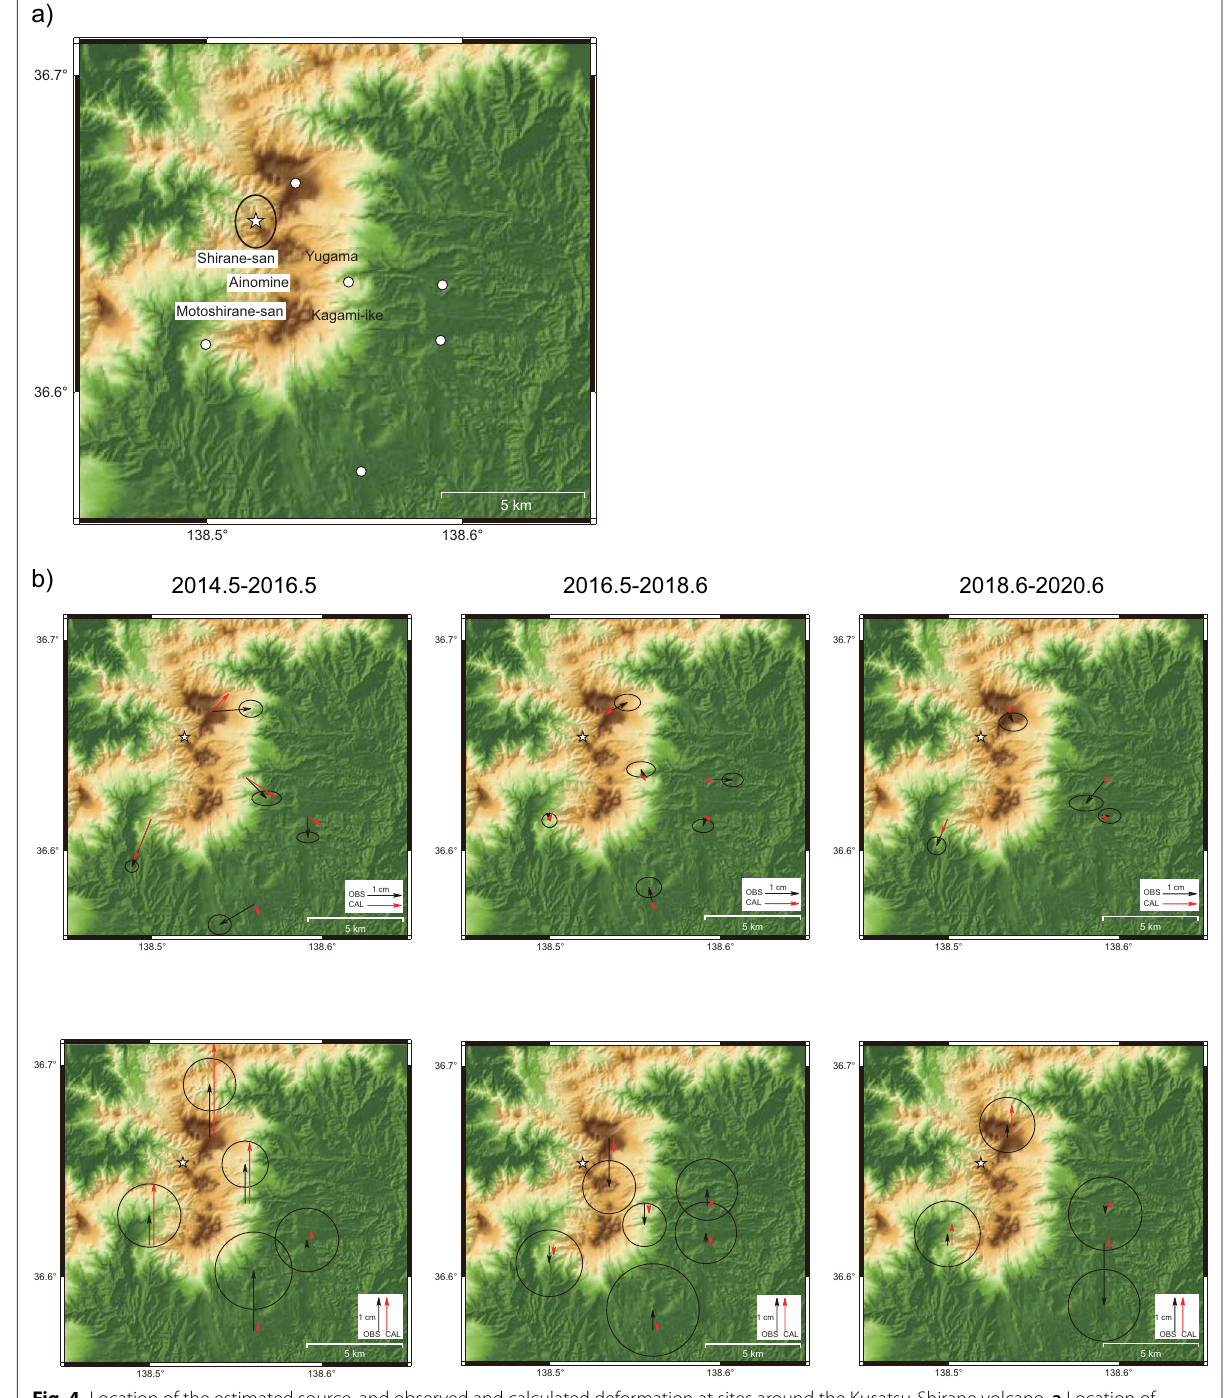
Fig. 4 Location of the estimated source, and observed and calculated deformation at sites around the Kusatsu-Shirane volcano. a Location of the estimated source. The estimated source is represented with a star. An accompanying solid ellipse represents an error ellipse (one sigma). White circles represent the location of the observation sites. b Observed and calculated deformation. Observed and calculated deformation are represented by black and red arrows, respectively. The top three panels show horizontal deformation for three periods (from May 2014 [epoch #17] to May 2016 [epoch #42], May 2016 [epoch #42] to June 2018 [epoch 67], June 2018 [epoch #67] to June 2020 [epoch #92]) and the bottom three panels indicate vertical deformation. Error ellipses reflect one sigma observation